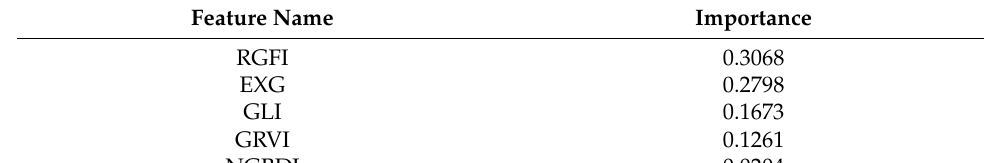
Table 2. Feature screening results of RF.